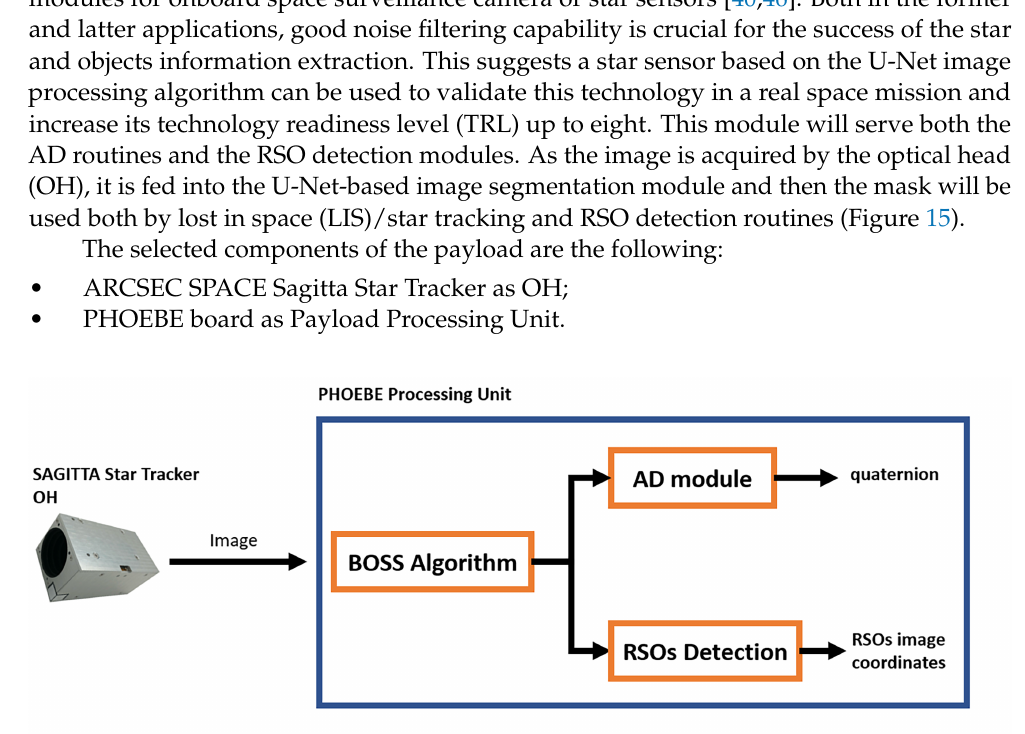
Figure 15. Payload architecture and the role of the BOSS algorithms (for the OH SAGITTA, Credits to ARCSEC